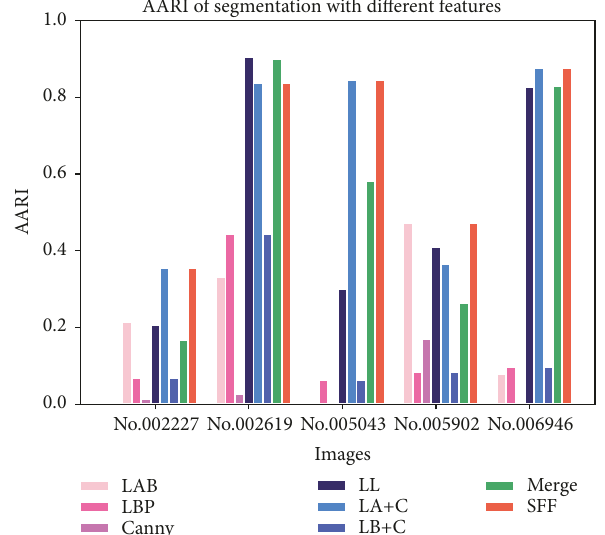
Figure 4: AARI of five example images segmented by different features, where LL represents LAB+LBP. LA+C represents LAB+Canny. LB+C represents LBP+Canny. Merge represents combination feature of LAB, LBP, and Canny.